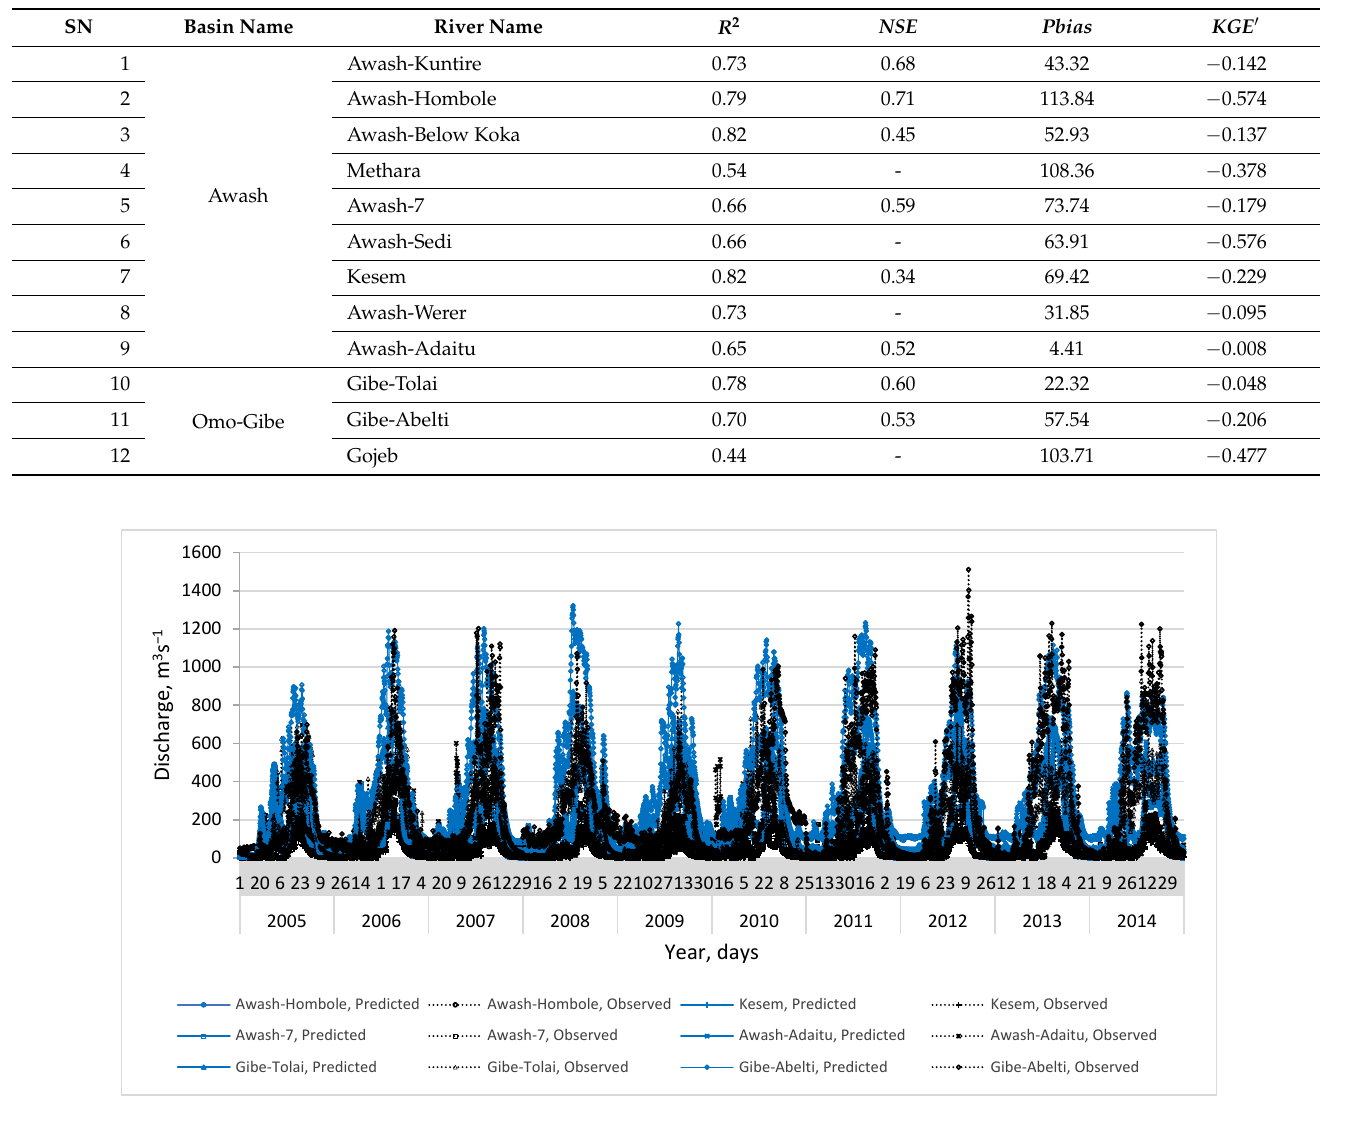
Table 1. Flood inundations in the model basins based on model and satellite observations.